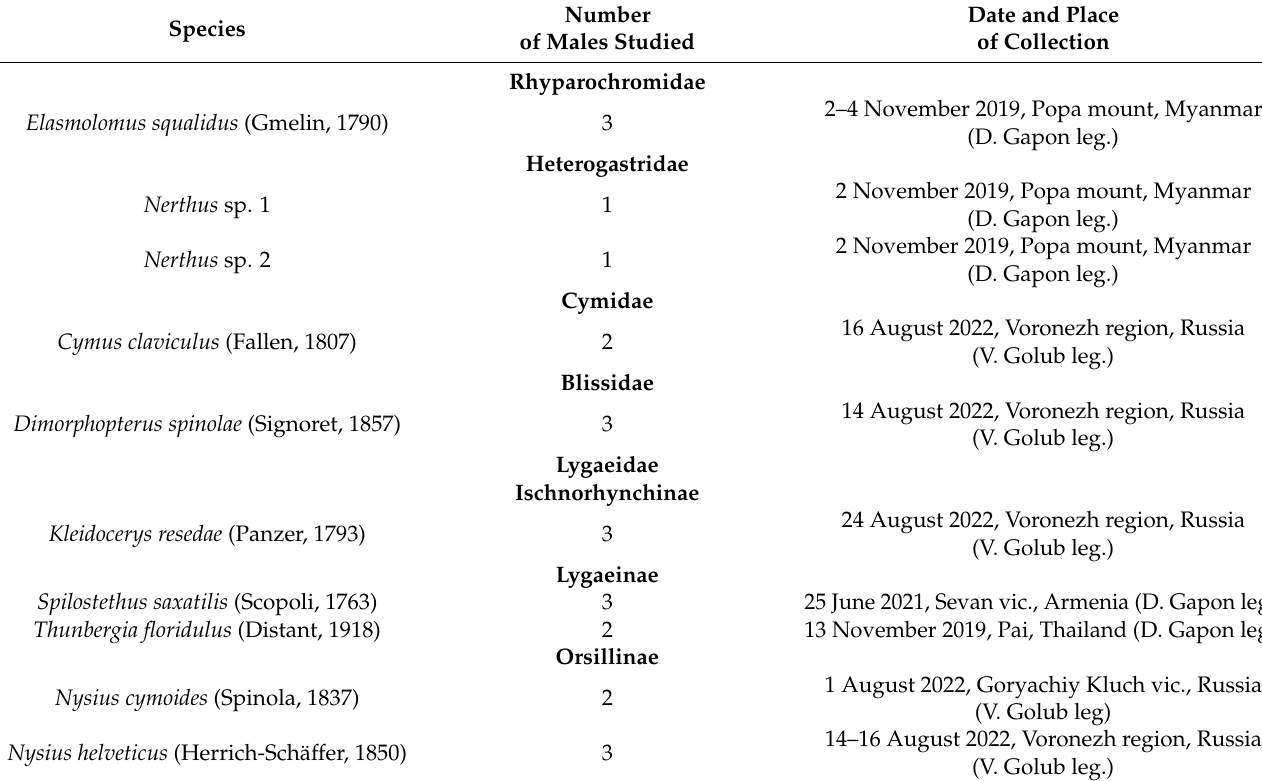
Table 1. Localities of the material used for chromosome